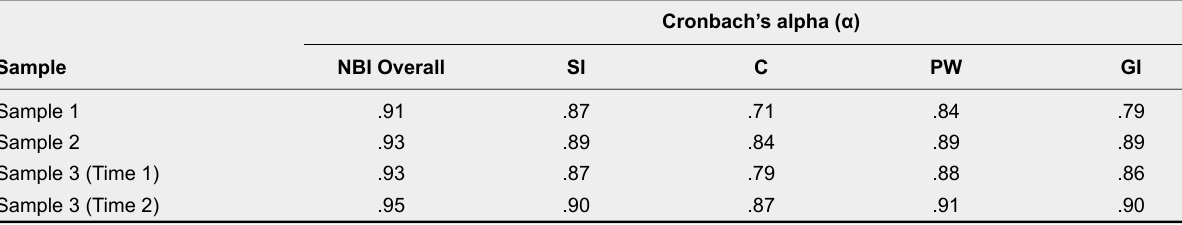
Internal Consistency of the NBI and Subscales Across Samples